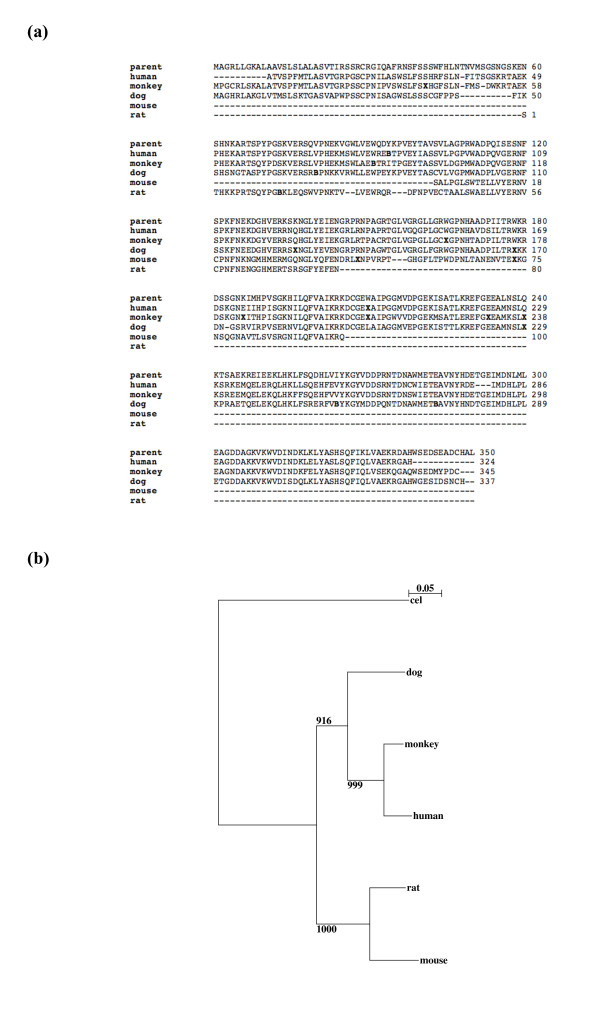
Multiple sequence alignment and phylogenetic analysis of a human transcribed pseudogene that has orthologs in the ≥2 other mammals. (a) Multiple sequence alignment of conceptually-translated ortholog sequences (urn:lsid:pseudogene.org:9606.Pseudogene:4346; see Additional file 2: Table S2) from different mammals along with the human parental protein sequence (human ADP-ribose pyrophosphatase, swissprot accession id: NUDT9_HUMAN). The positions of stop codons in the alignment are denoted by 'X' and frameshifts denoted as 'B'. (b) A rooted phylogenetic tree constructed from the most conserved segment from a multiple nucleotide sequence alignment between ortholog sequences (human parental protein sequence - ADP-ribose pyrophosphatase, swissprot accession id: NUDT9_HUMAN). As an outgroup, we chose a protein sequence from C.elegans from the 'nudix' hydrolase family but belonging to another subfamily (NDX2_CAEEL) identified based on BLAST matching. PHYLIP Bootstrap support values out of 1000 iterations are indicated at each node.